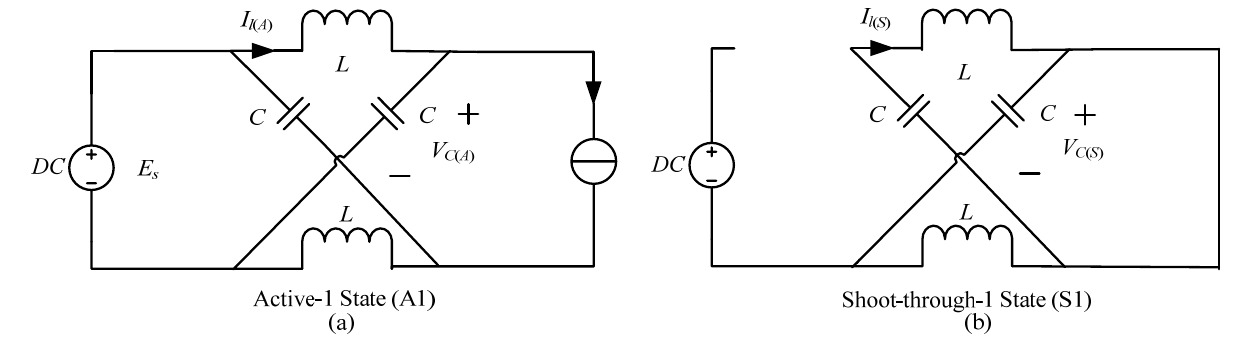
Figure 3. ( a ) Active-1 State; ( b ) Shoot-through-1